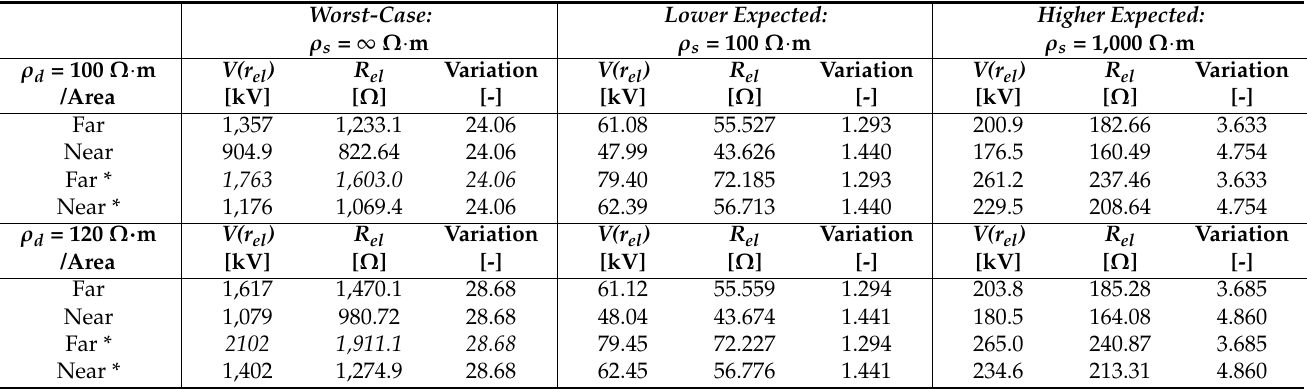
Table 5. Absolute potential at electrode surface V(r el ) and equivalent electrode resistance R el in the area of Korakia (Crete), in relation to the neighboring coasts based on method “B” according to Equations (27) and (28) and variation in corresponding values in relation to method